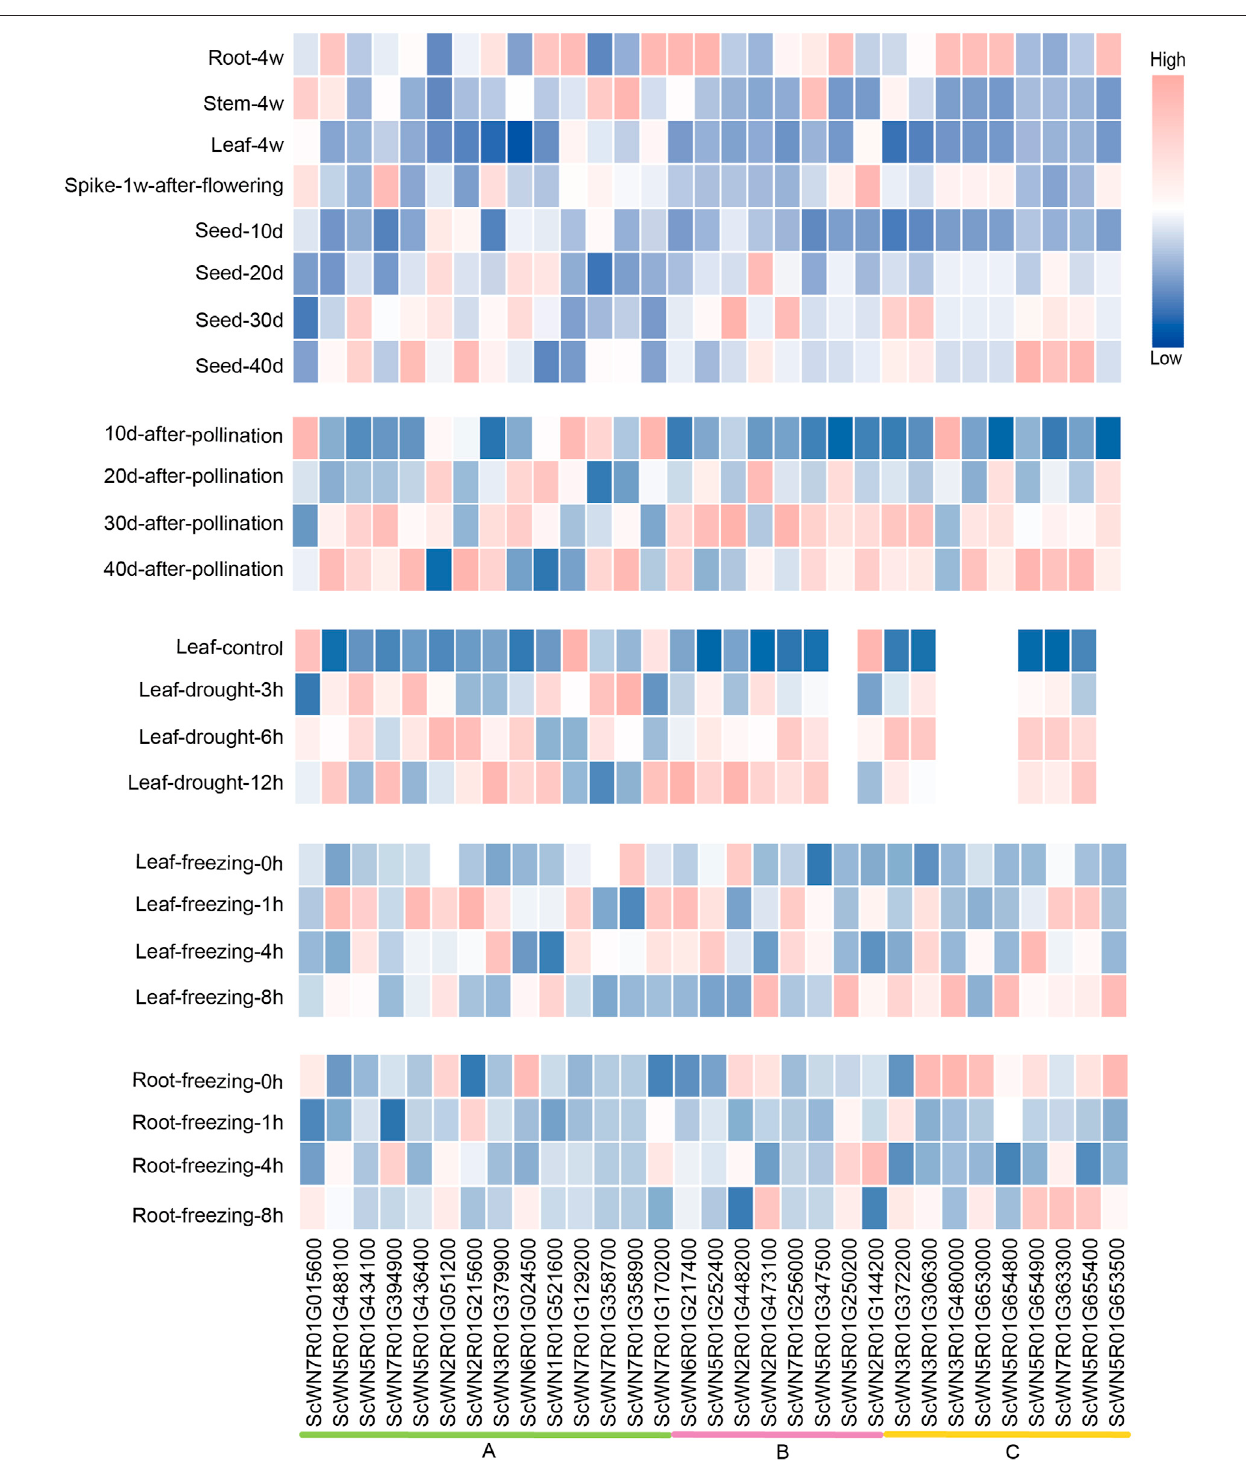
FIGURE 4 | Expression analysis of HSF genes in S. cereale across different tissues, development stages and different stress treatments.